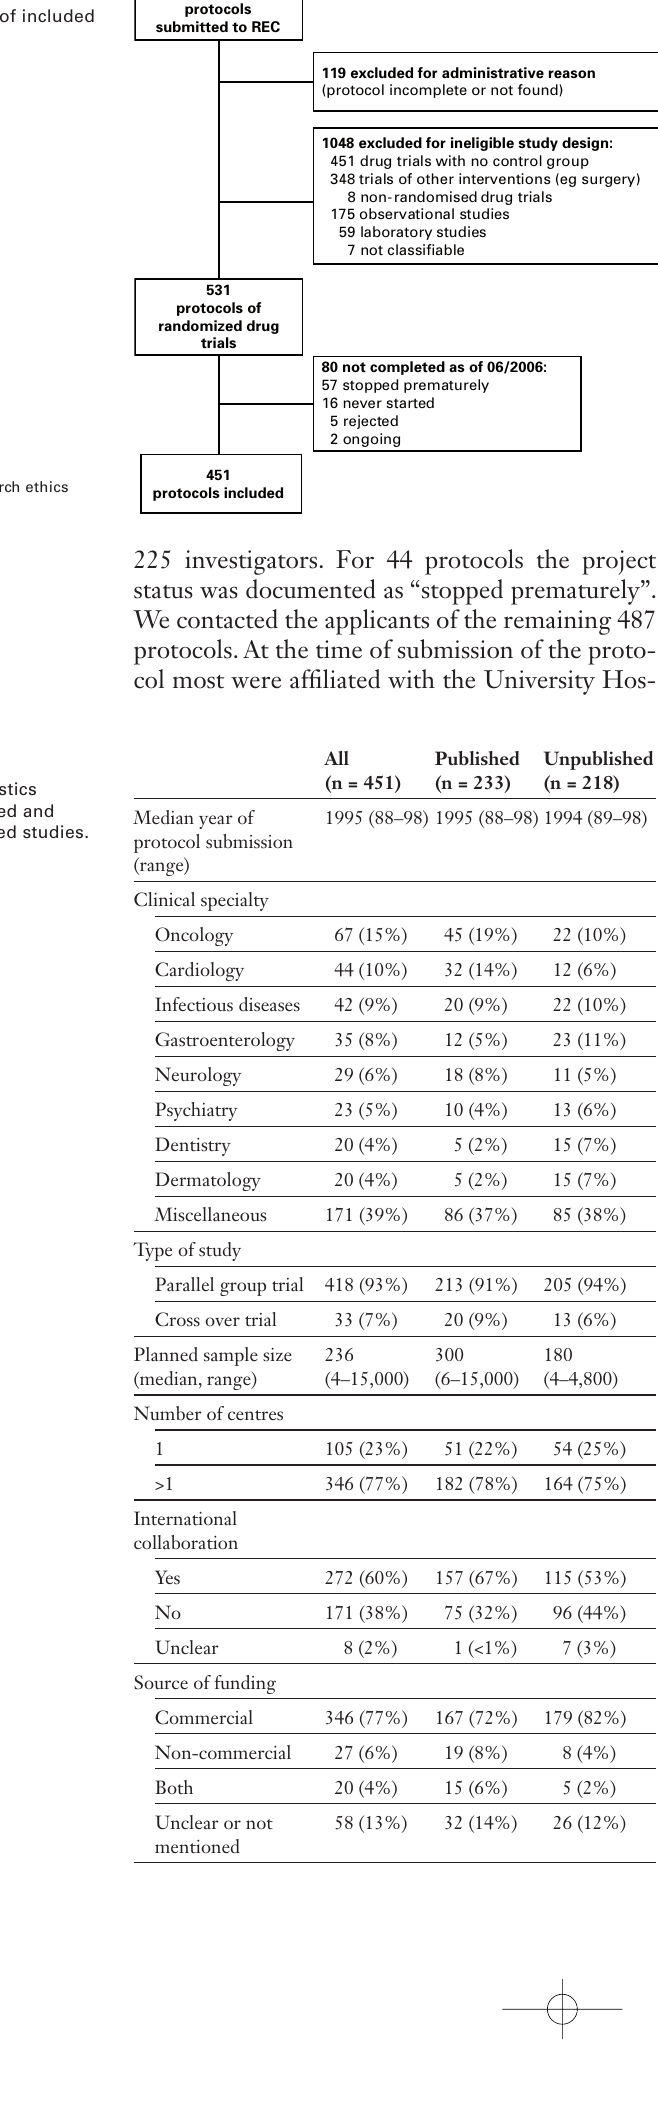
Flowchart of included protocols.